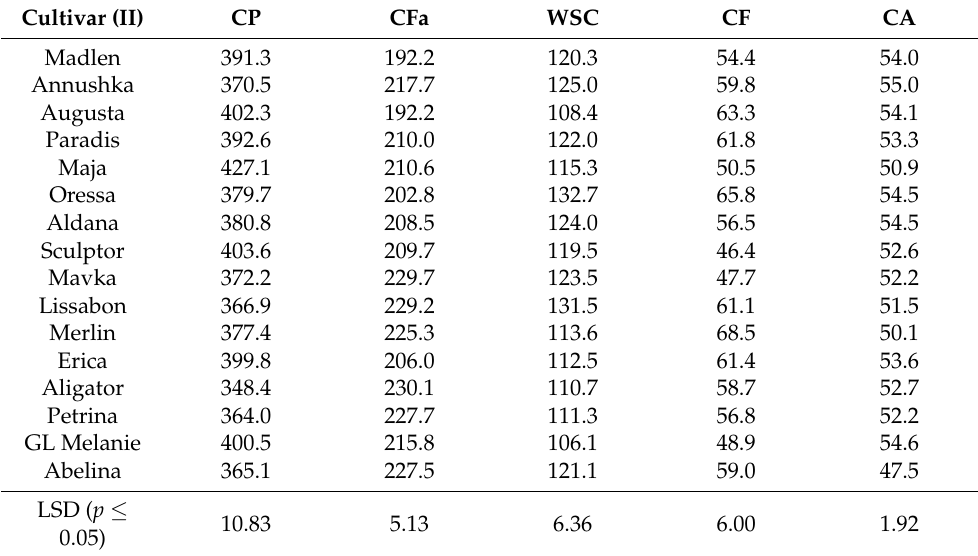
Table 5. Chemical composition of soybean seeds (g kg − 1 ) depending on cultivar (n = 10). Cultivar